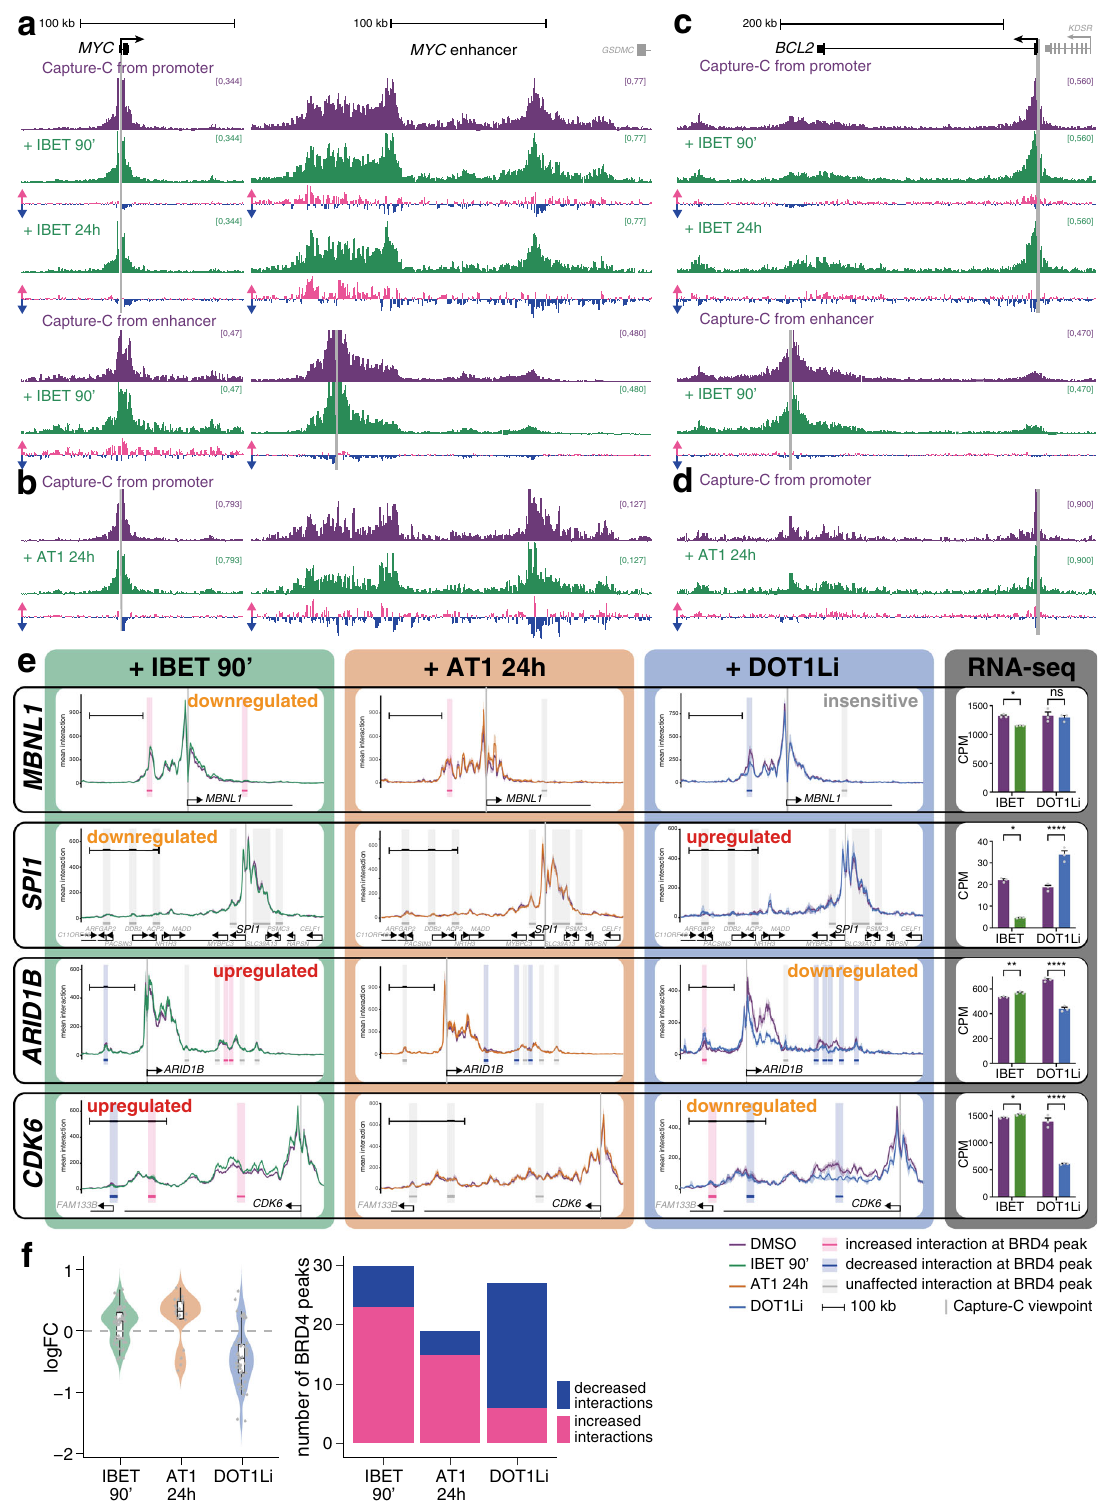
BCL2 enhancers, we found very little evidence for a loss of interaction with their cognate promoters despite the reduction in transcription. similar lack of changes in interaction frequency following hexanediol treatment (Fig. 4g, Supplementary Data 3), regardless of the transcriptional change at the gene (Supplementary Fig. 4f).